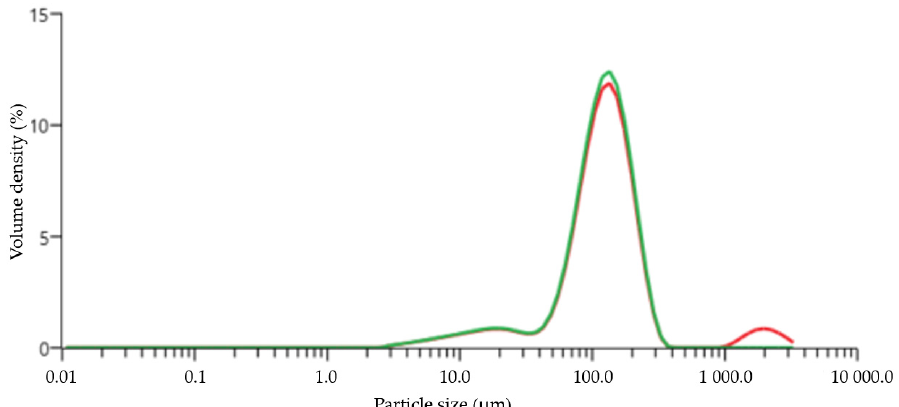
Figure A1. Example of the error observed between a raw (red) and corrected (green) particle size distribution.